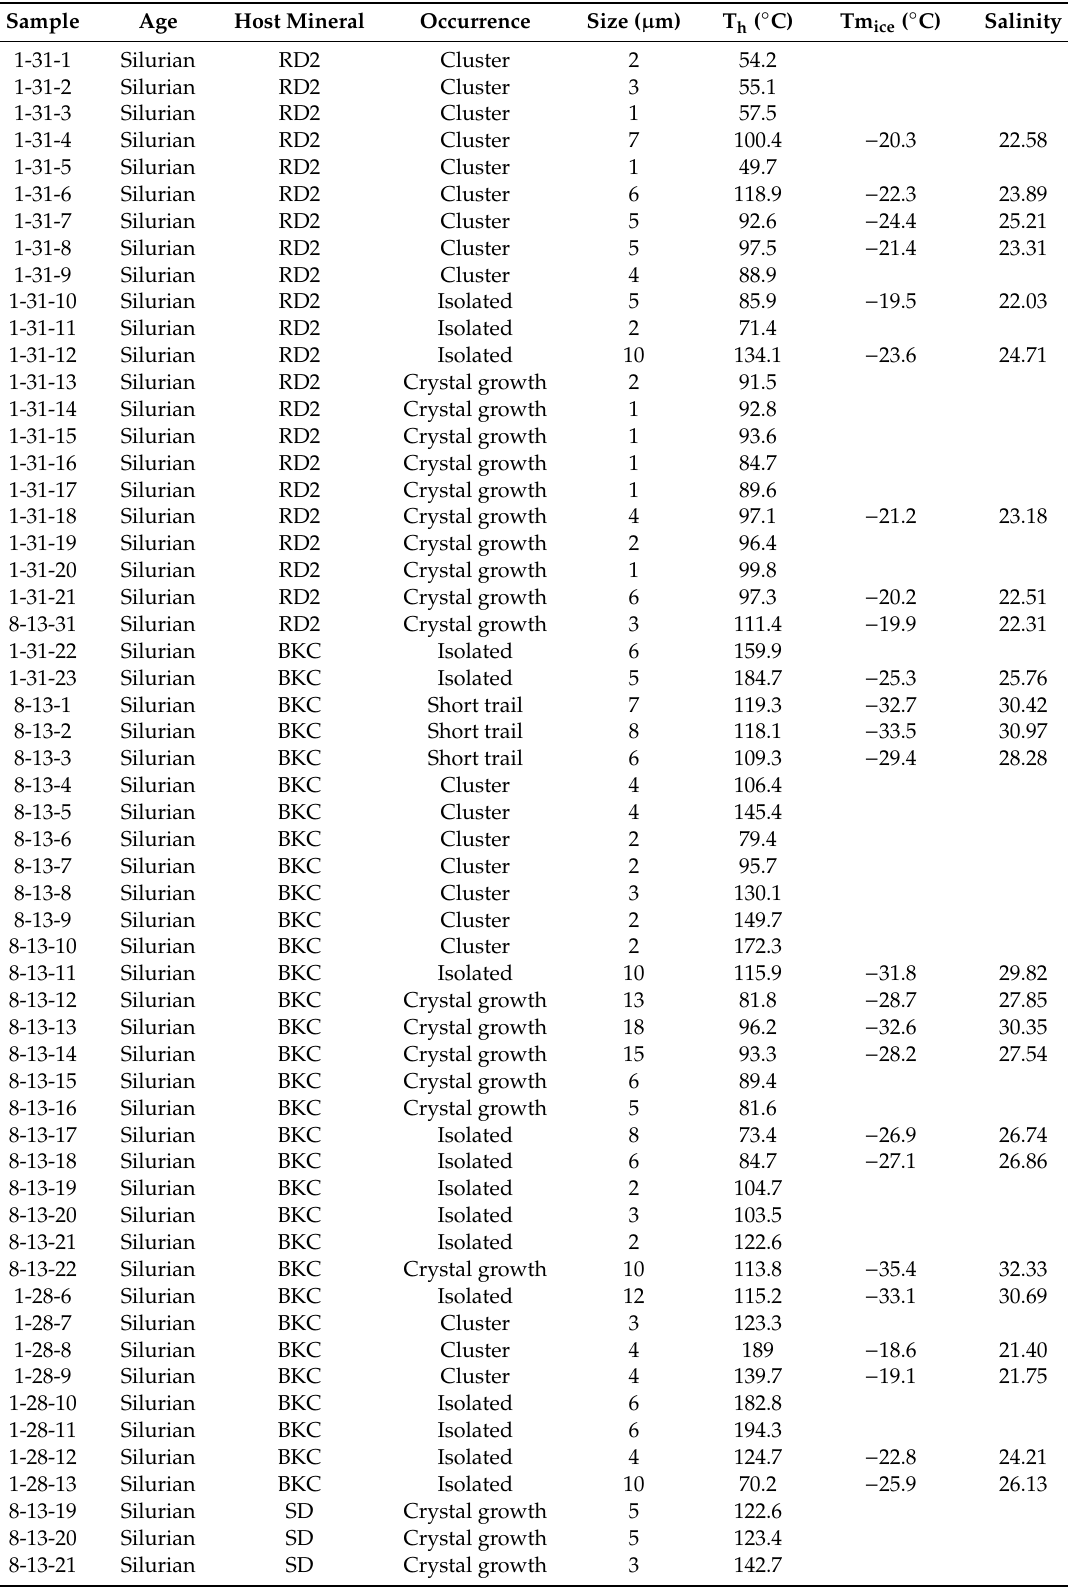
Table 4. Fluid inclusions